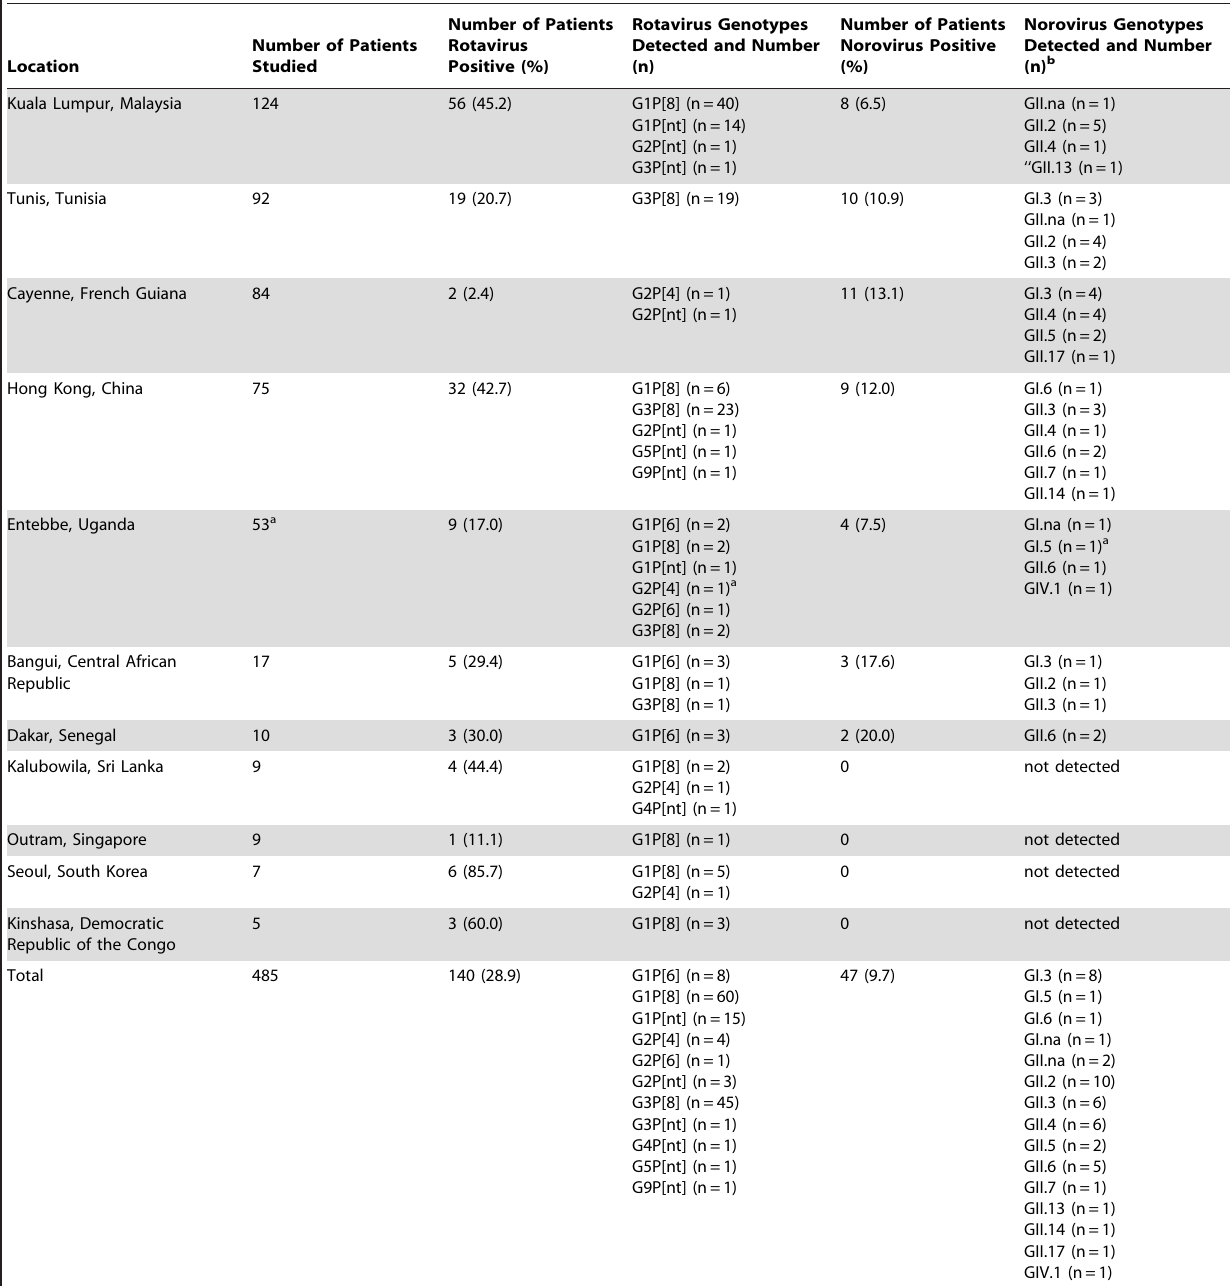
Table 1. Distribution of Viral Genotypes Detected in Each Geographic